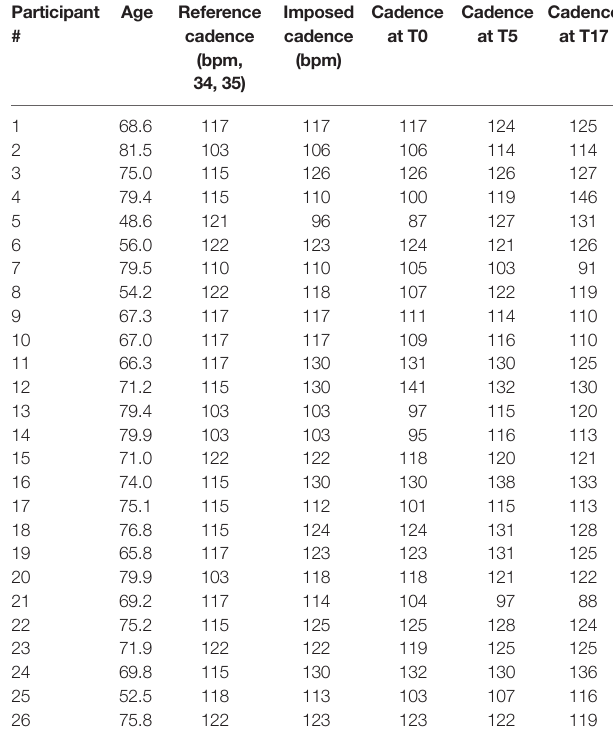
Table 3 | cadence values for each participant before and after rehabilitative treatment.